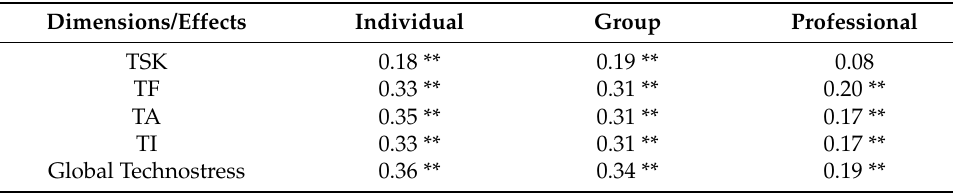
Table 7. Pearson’s correlations between technostress and effects.